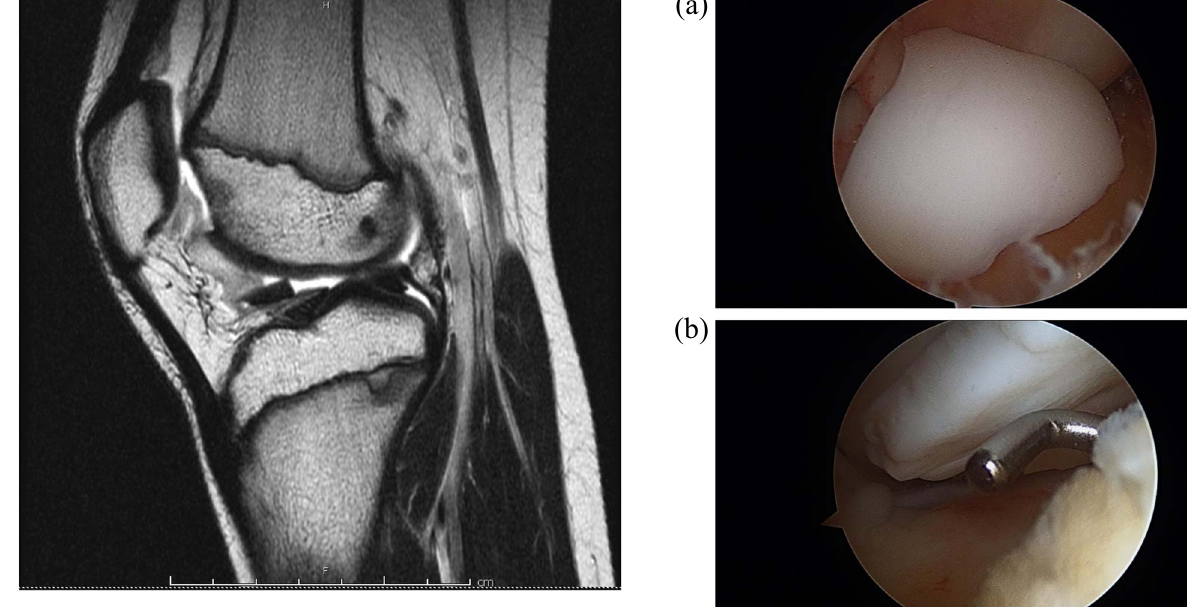
Figure 3. T1-weighted MRI showing full-thickness cartilage defect at the lateral femoral condyle.